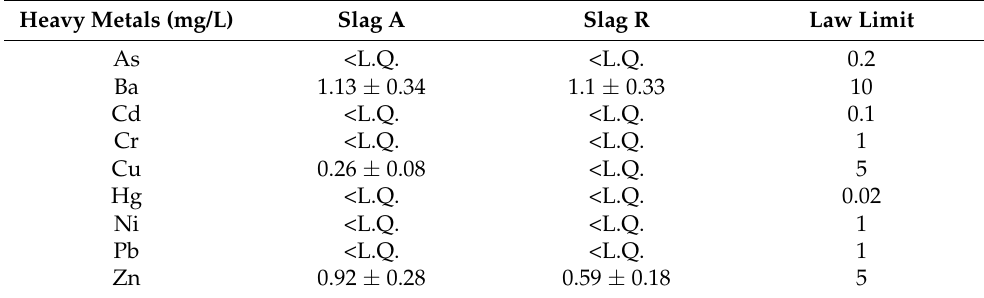
Table 3. Heavy metals (mg/L) in the slag A/R eluates after leaching test in water (EN 12457-2). Heavy Metals (mg/L)